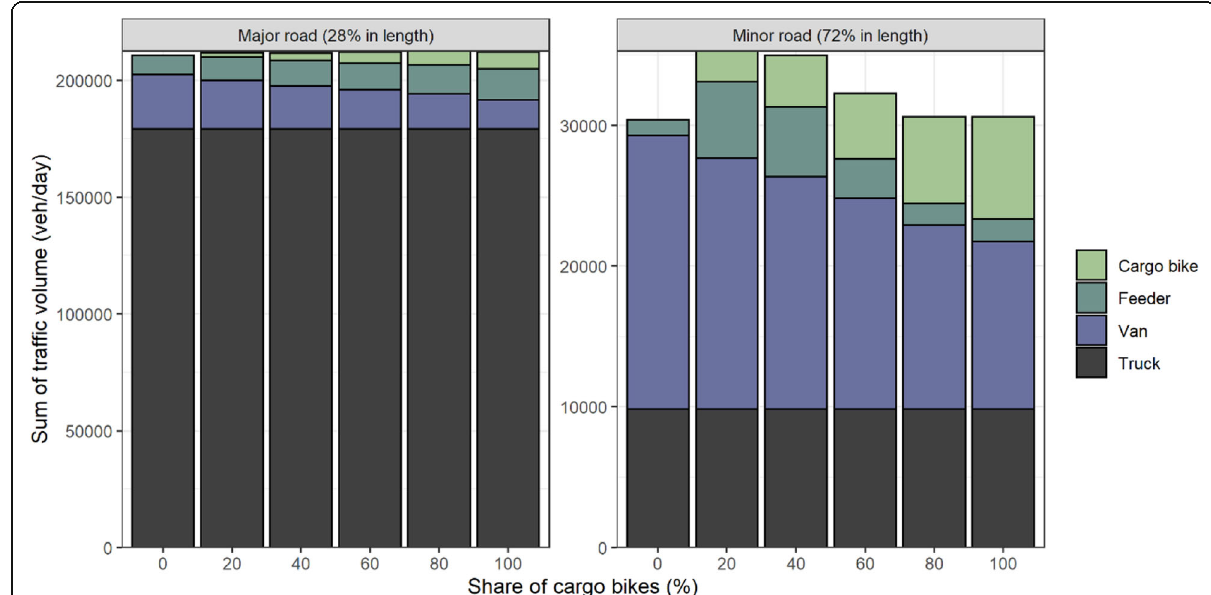
Fig. 7 Link counts of urban freight vehicles by road type and freight vehicle type in the catchment area of the analyzed Munich distribution